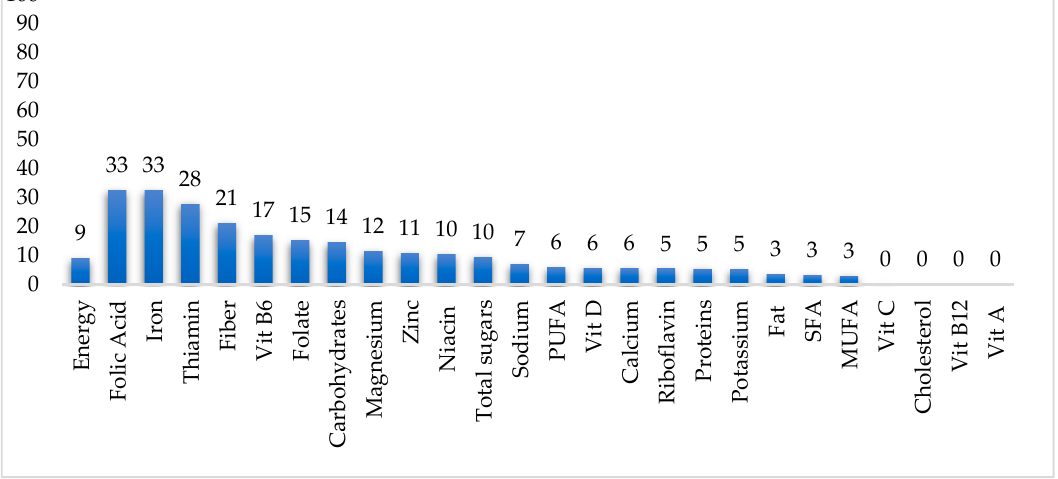
Figure 1. Contribution (%) of ready-to-eat cereal (RTEC) to daily nutrient intake among RTEC consumers ( n = 7,354,198) 1 . Data source: Canadian Community Health Survey, Nutrition-2015. 1 All data are weighted and bootstrapped to obtain estimates at the Canadian population level. RTEC consumers were defined as those individuals who reported any quantity of ready-to-eat cereal consumption on day 1 of the 24-h recall. MUFA: monounsaturated fatty acids, PUFA: polyunsaturated fatty acids, SFA: saturated fatty acids, Vit: vitamin.